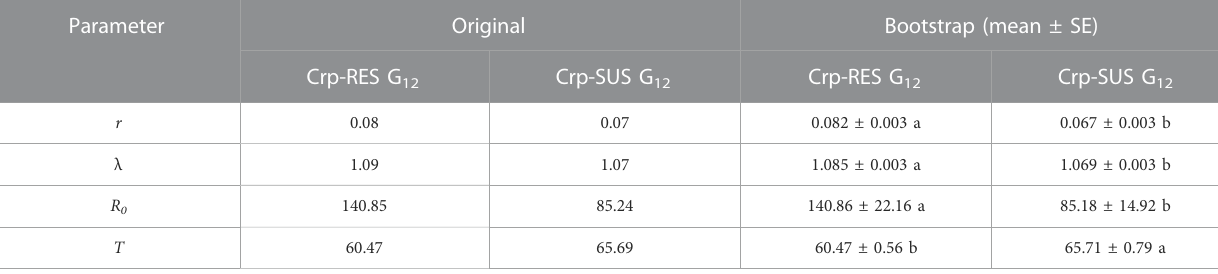
TABLE 5 Population parameters for the Crp-RES G 12 and Crp-SUS G 12